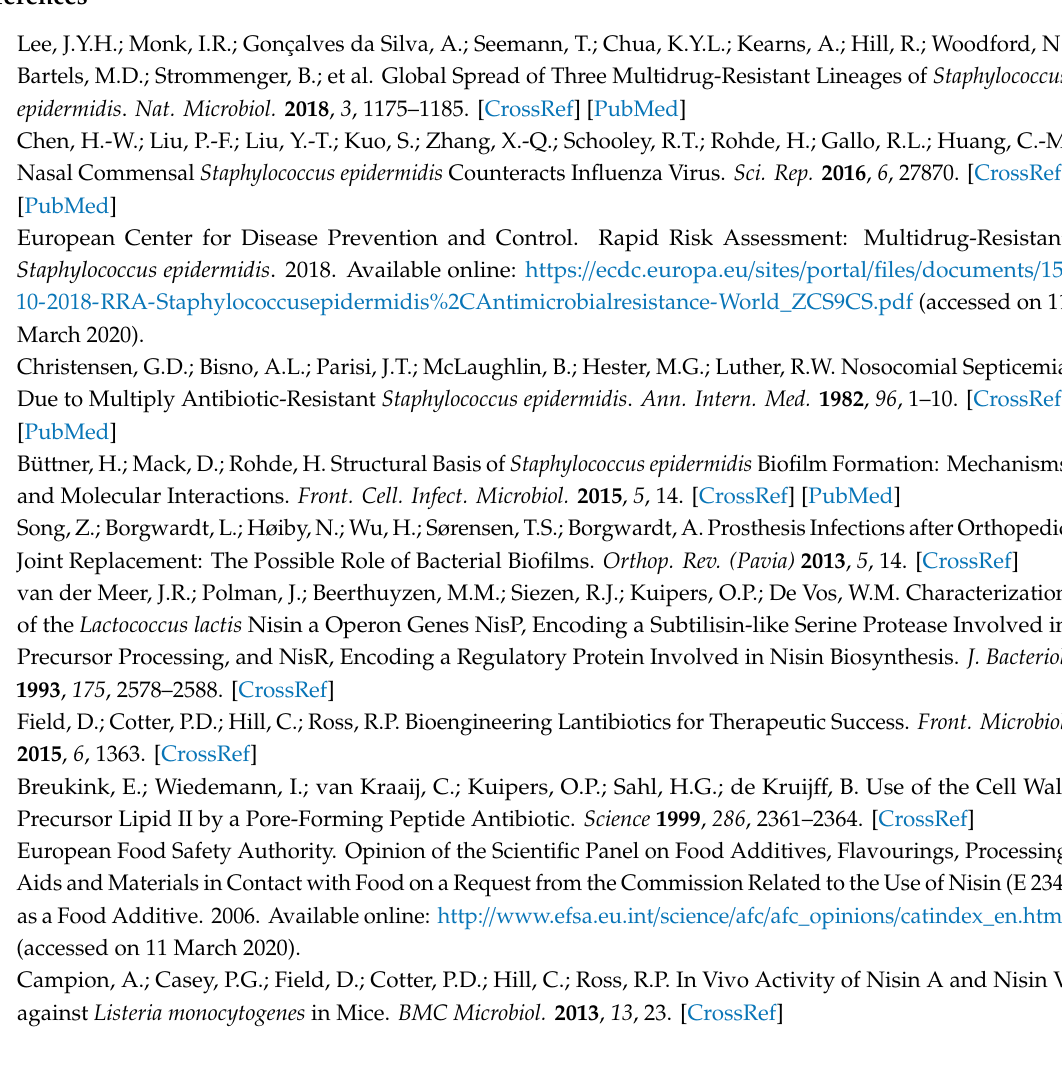
Figure S1: ( A ) Structure of the nisin peptide indicating the M17Q substitution ( B ) Amino acid sequence of nisin peptide and M17Q derivative peptide. Figure S2: Reversed–phase high performance liquid chromatography (RP-HPLC) profile for (A) derivative peptide M21V, (B) derivative peptide M17Q and (C) wildtype peptide nisin A. Figure S3: Chromatogram displaying MALDI-TOF Mass Spectrometry of lyophilized peptides, wildtype nisin A and derivative peptide